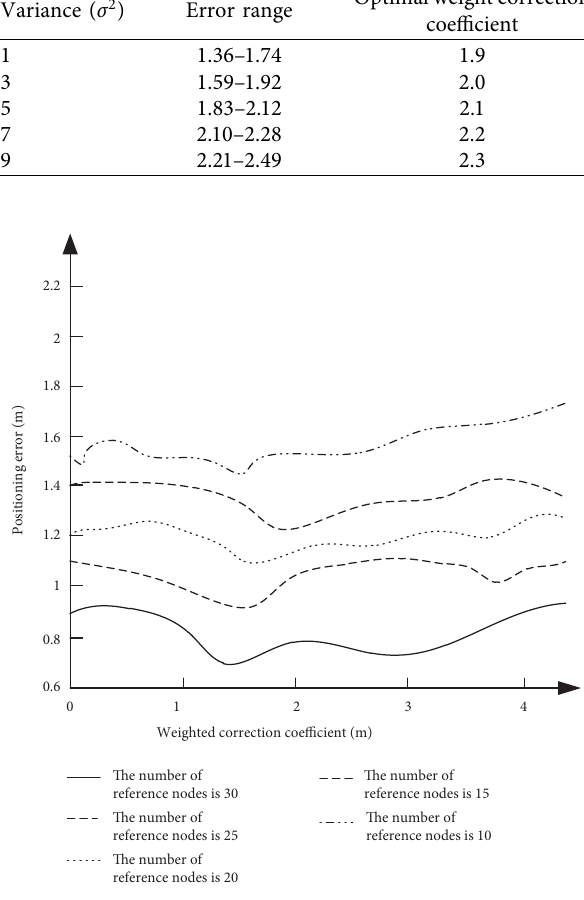
Figure 11: Reference node number influence